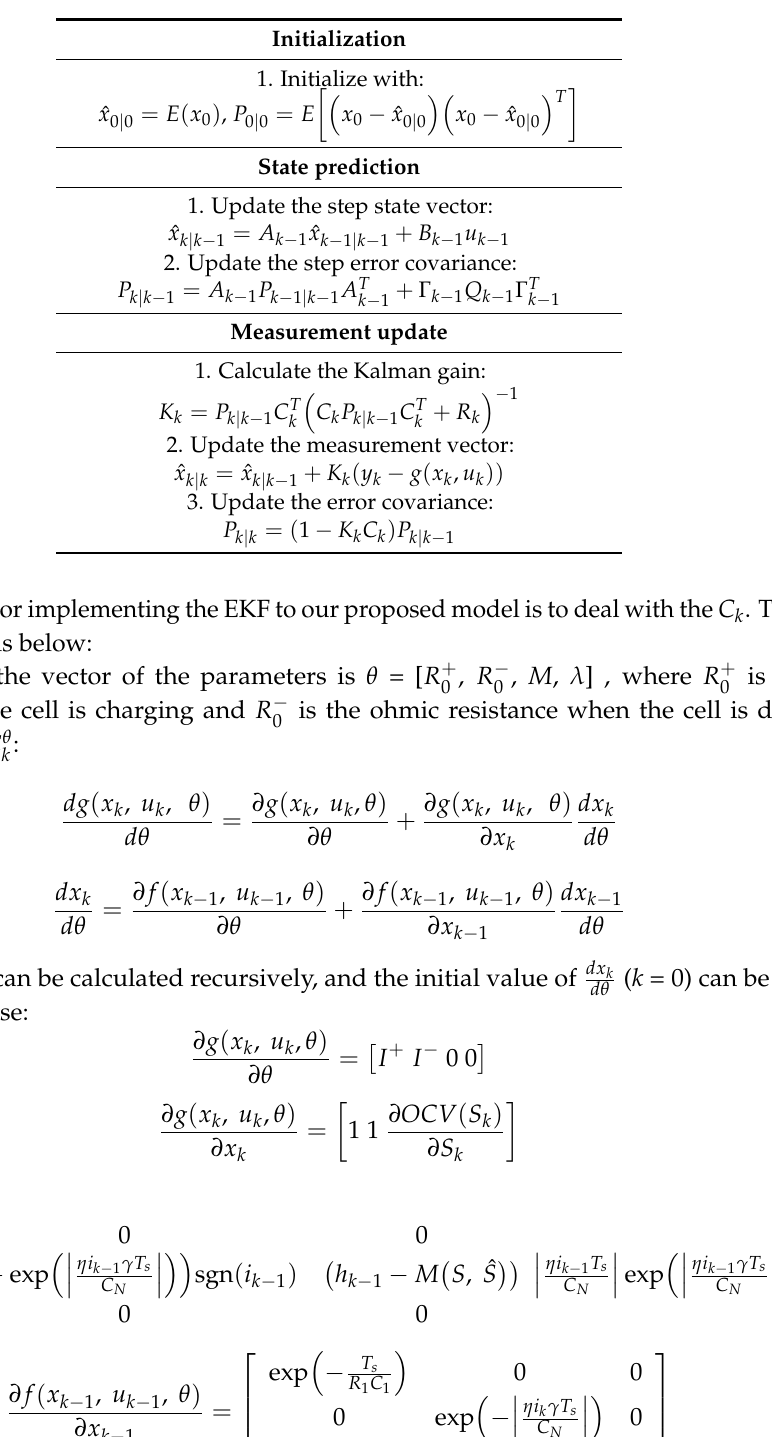
Table 2. Summary of the extended Kalman filter (EKF) approach for SOC